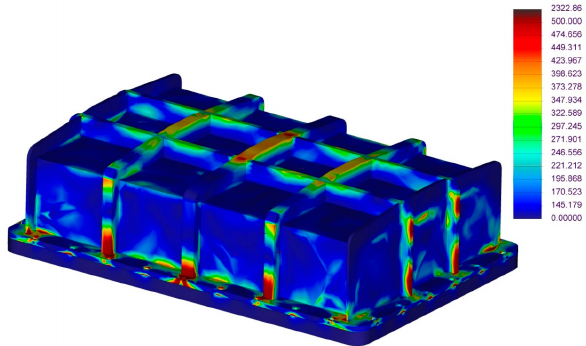
Figure 8. Computational model of the top cover assembly.